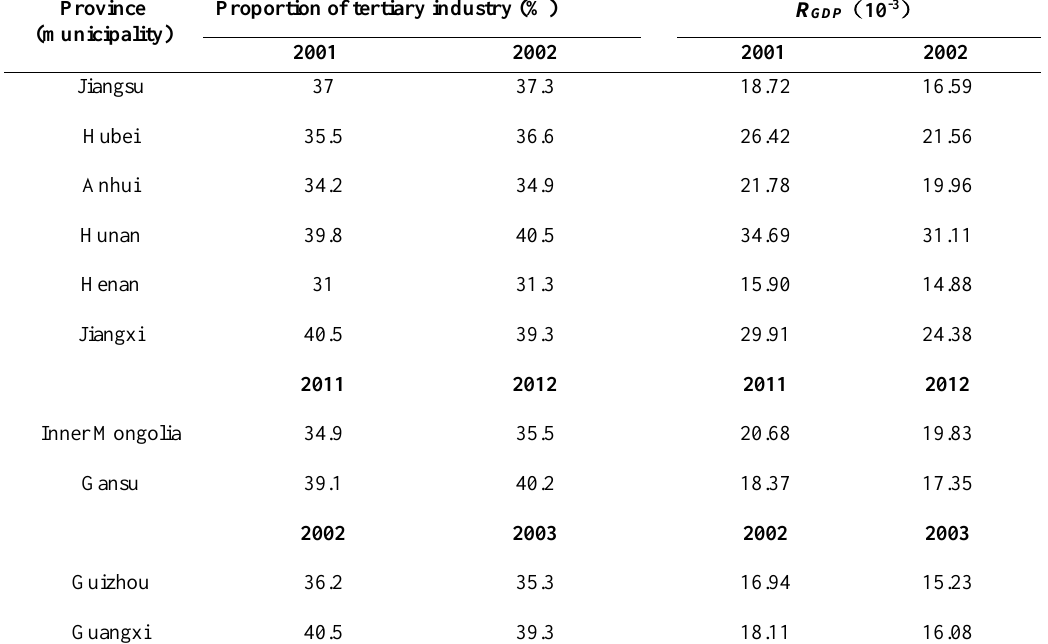
Table 2. The variation in proportion of tertiary industry and R GDP